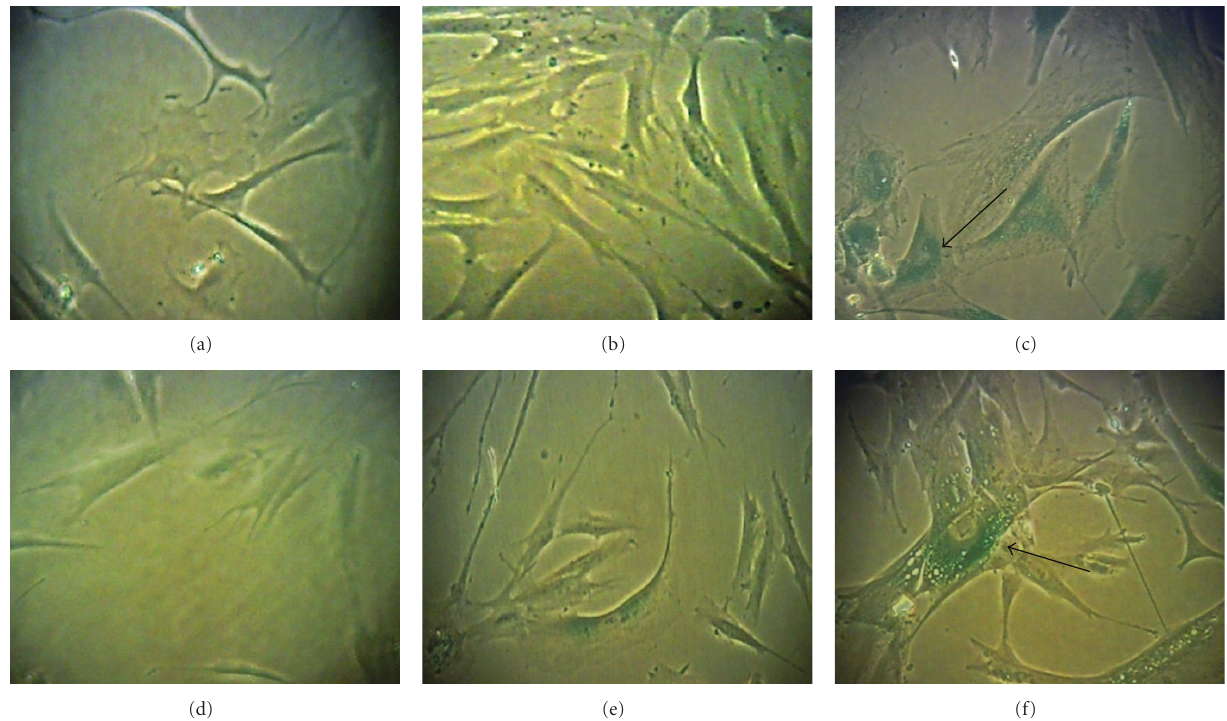
Figure 3: β -Galactosidase staining in young (a), presenescent (b) and senescent HDFs (c) compared to TRF-treated HDFs (d)–(f). Positive blue stain of SA - β -galactosidase appeared in senescent HDFs as indicated by arrow. Micrographs are shown at 200x